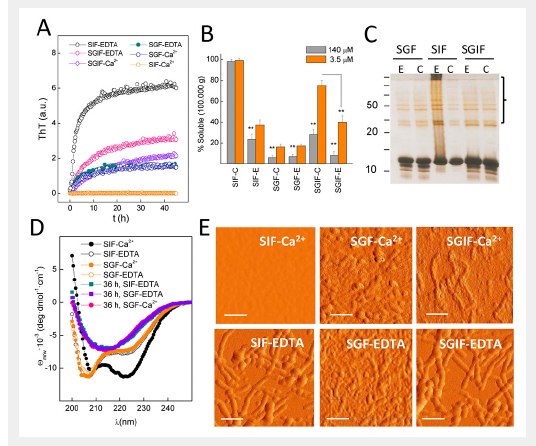
Amyloid-like aggregation of cod β-parvalbumin. ( A ) Kinetics of thioflavin T (ThT) binding indicate rGad m 1 fibril formation under simulated gastric fluid (SGF), simulated intestinal fluid (SIF) supplemented with 5 mM EDTA and simulated gastrointestinal fluid (SGIF) containing either 5 mM EDTA or 5 mM CaCl 2 . Reactions were performed at 37 °C using 140 μM rGad m1, and the measured fluorescence counts normalised. ( B ) Percentage of soluble rGad m 1 recovered in the supernatants of a 100,000 x g centrifugation after 36-h incubations in SIF, SGF and SIGF, supplemented with 5 mM EDTA (E) or 5 mM CaCl 2 . (C) show formation of insoluble aggregates under those conditions with increased ThT binding. Incubations were performed at 3.5 and 140 μM rGad m 1. Solubility percentages were determined by measuring the protein concentration in both the soluble and the pellet fraction using triplicates. Bar charts are presented as mean±standard deviation (n = 3); ** p <0.05. ( C ) Analysis of rGad m 1 aggregates by use of sodium dodecyl sulfate polyacrylamide gel electrophoresis (SDS- PAGE) and silver staining shows bands at high molecular weight corresponding to SDS-resistant aggregates. ( D ) Circular dichroism (CD) spectra of 60 μM rGad m 1 in SGF and SIF supplemented with either 5 mM EDTA or 5 mM CaCl 2 indicate β-sheet structures after 36 h incubation of the apoforms. ( E ) Atomic force microscopy (AFM) images of rGad m1 incubated for 36 h under SGF, SIF and SGIF supplemented with 5 mM EDTA or 5 mM CaCl 2 indicating the formation of aggregates and of their fibrillar shape. Scale bars 100